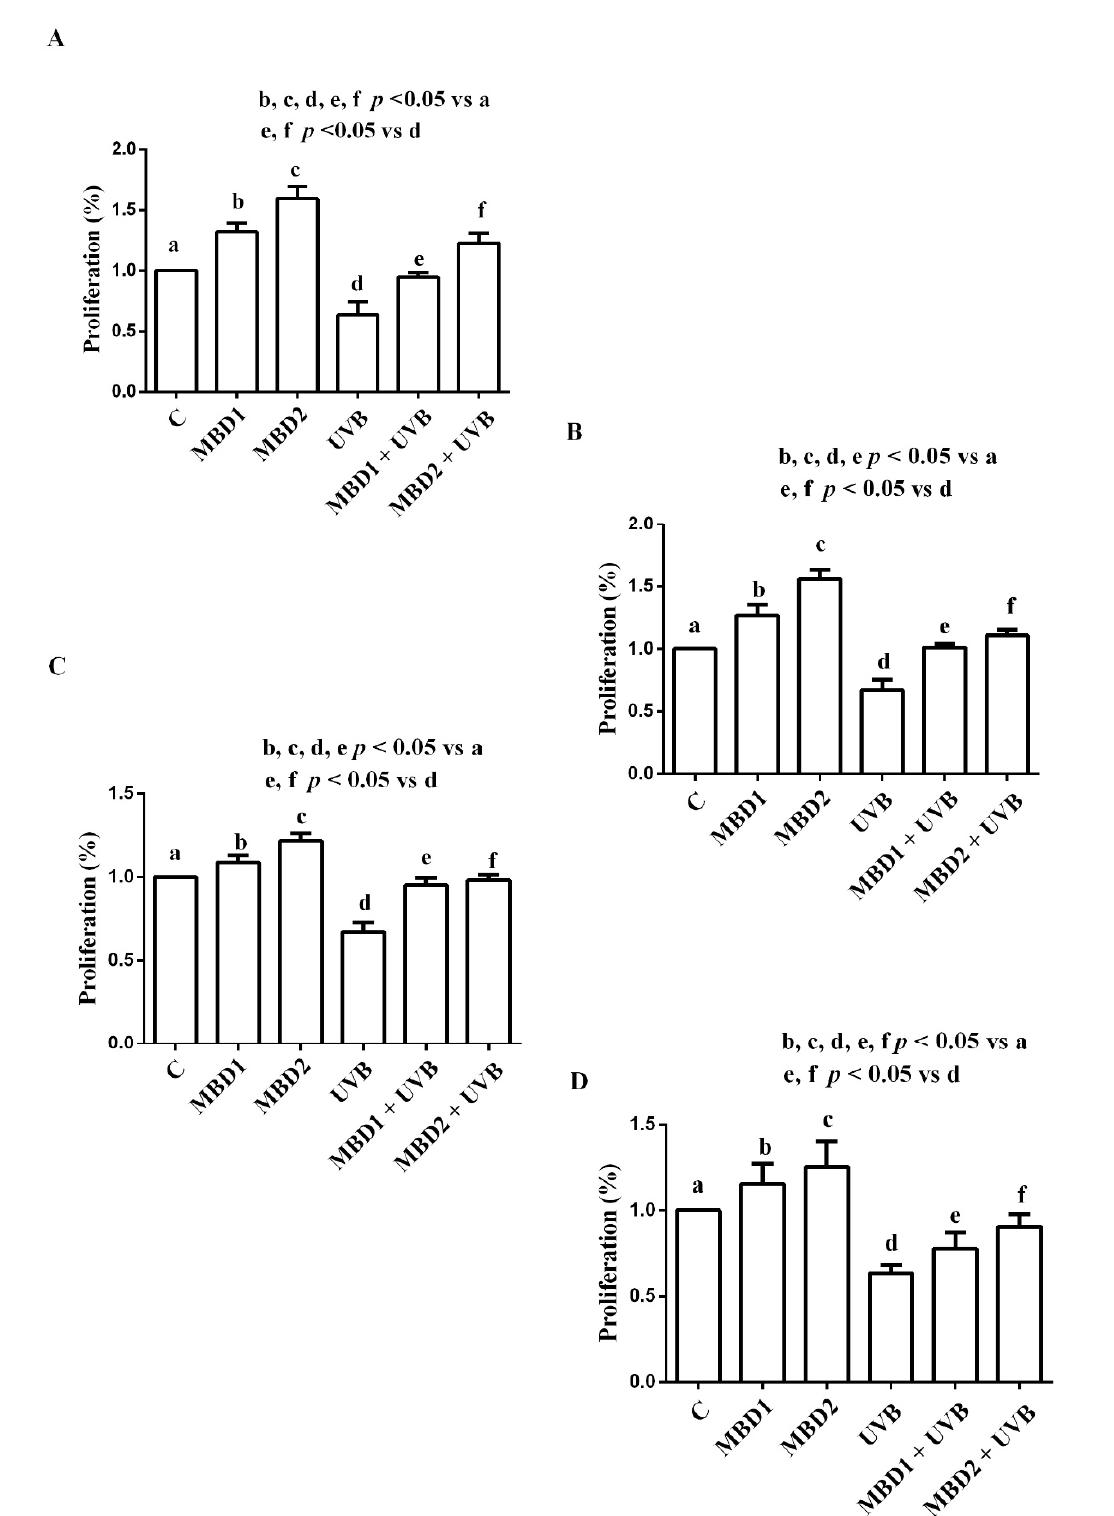
Figure 6. Effects of MBD with ( A , C ) and without PEG ( B , D ) on proliferation in ARPE-19 cells ( A , B ) and RGC-5 cells ( C , D ). MBD1: MBD at 3 × 10 − 5 M. MBD2: MBD at 7.8 × 10 − 4 M. UVB at 0.117 J/cm 2 (for 30 min). The results are means ± SD of repeated experiments. C: control cells (non-treated).